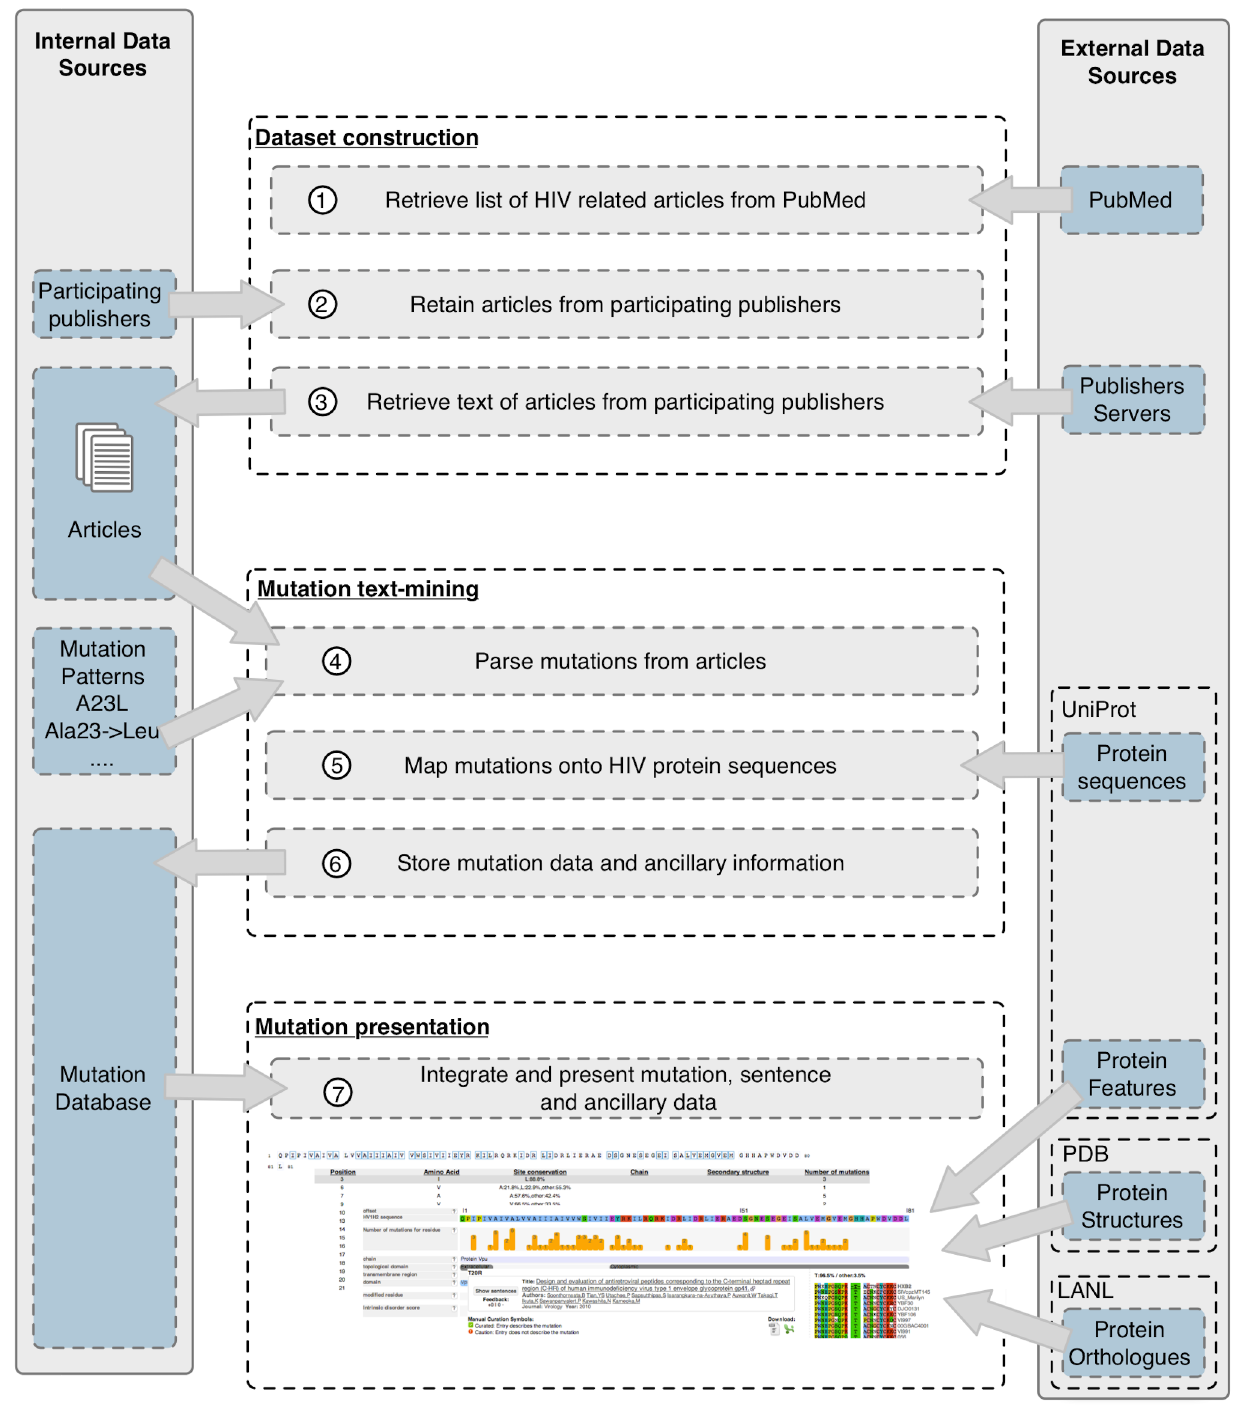
Figure 1. Schema describing article acquisition, mutation curation and data presentation for the HIV mutation browser. A list of HIV- related PubMed article identifiers (PMIDs) are retrieved from PubMed. The publishing journal of each article is compared against a list of participating publishers (i.e. publishers that have given permission for bulk PDF downloading, computational parsing of PDF and display of articles details). Permitted articles are retrieved from the publishers website as PDF files. Retrieved articles are computationally text-mined to parse patterns commonly used in the literature to denote mutations. Each mutation is then mapped onto the HIV proteome. Mutations are stored in a relational database and accessed through a web interface, the HIV mutation browser. The HIV mutation browser organises the data by protein and residue and integrates ancillary information relevant to the users. See methods section for more details.